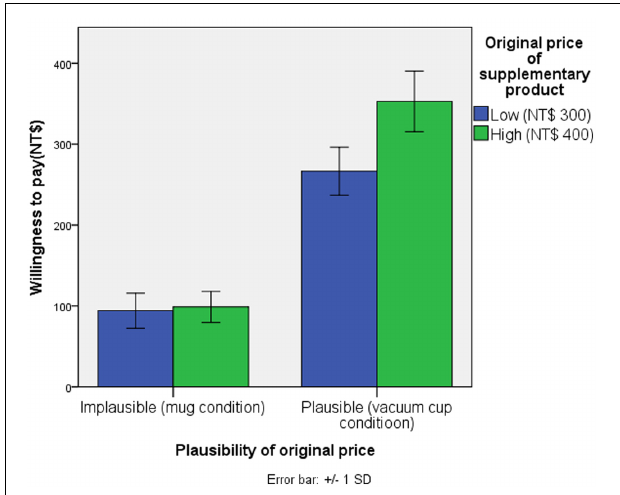
FIGURE 3 | Interaction between the original price and its plausibility of the supplementary